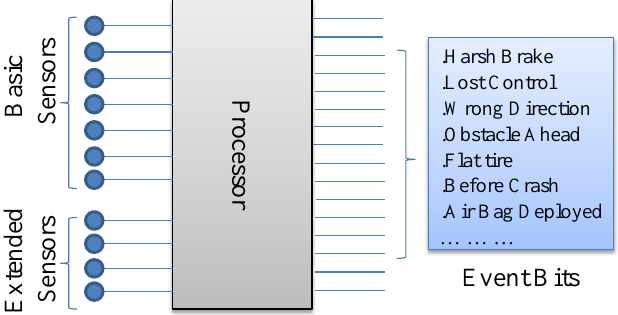
Figure 3. Sensory data to events